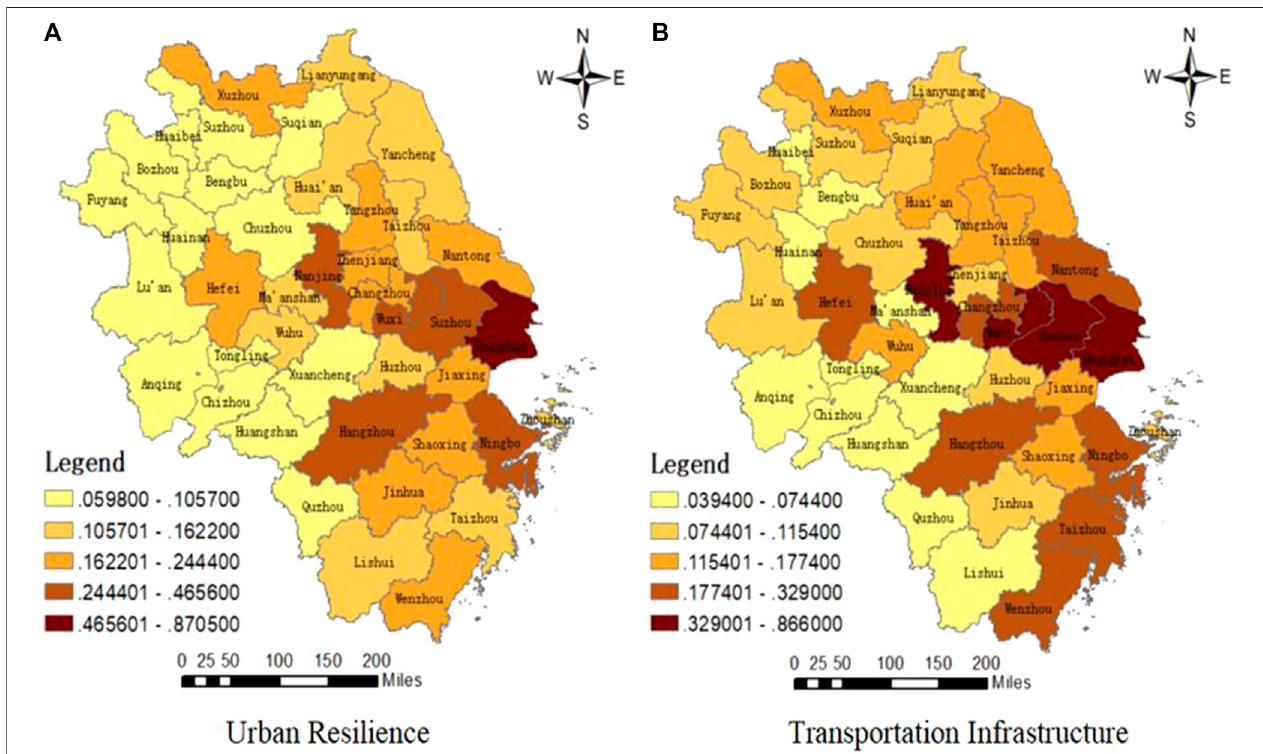
FIGURE3| SpatialdistributionpatternoftheoverallaveragevalueofurbanresilienceandthetransportationinfrastructurelevelintheYangtzeRiverDeltafrom2008 to